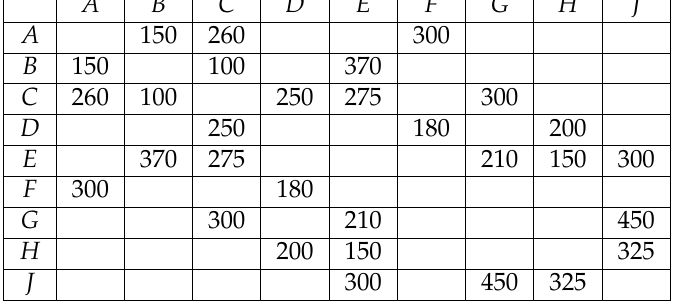
Figure 3. Distances in kilometers between cities.